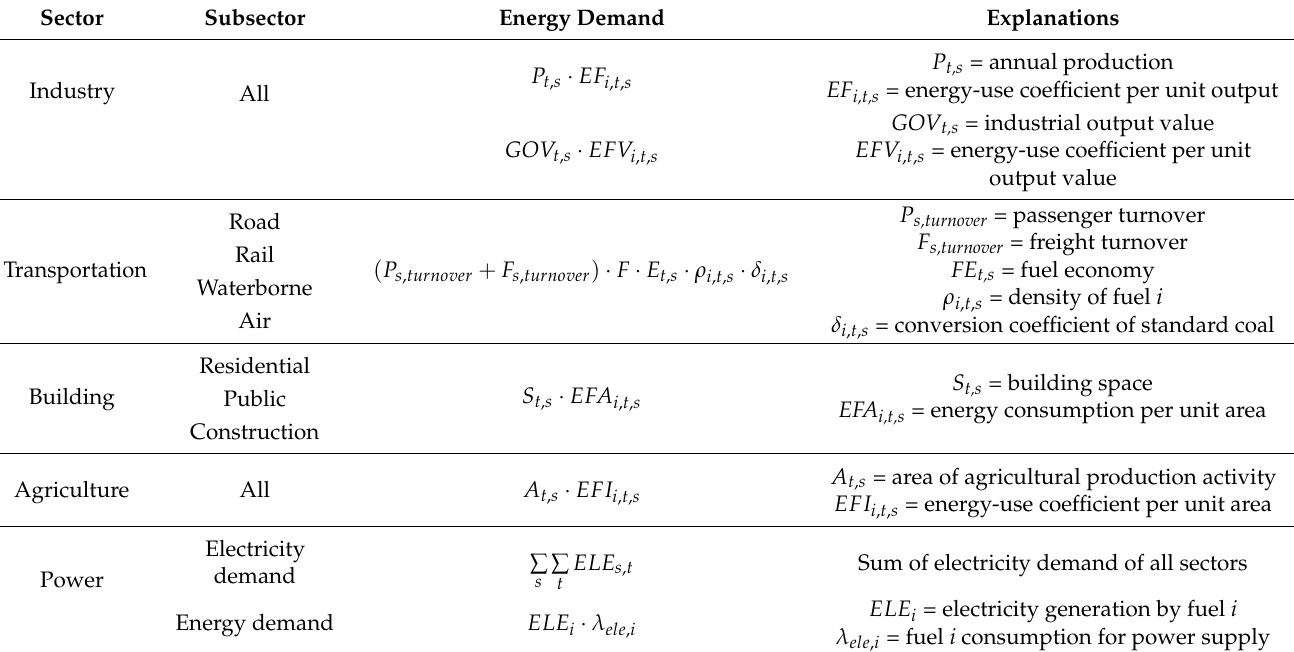
Table 1. The expressions for energy demand in different sectors